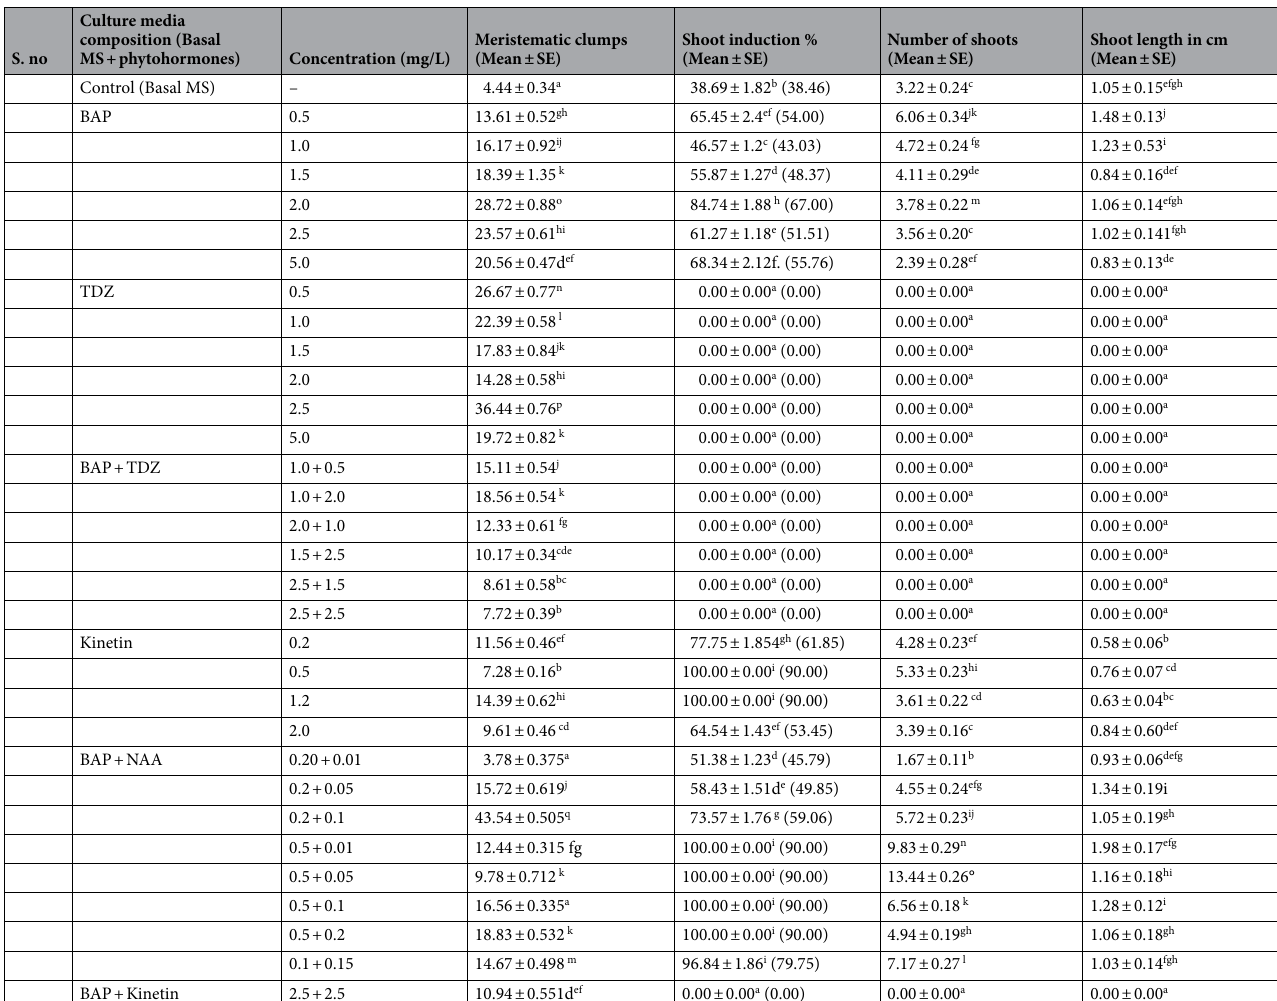
Table 1. Effects of different phytohormone combinations on in vitro multiplication of Xanthosoma sagittifolium. Data represents mean ± SE of six replicates per treatment in three repeated experiments. Means within the same column followed the different letters are significantly different according to Duncan’s multiple range test (DMRT) at 5% level. Arc sine transformation values are given in